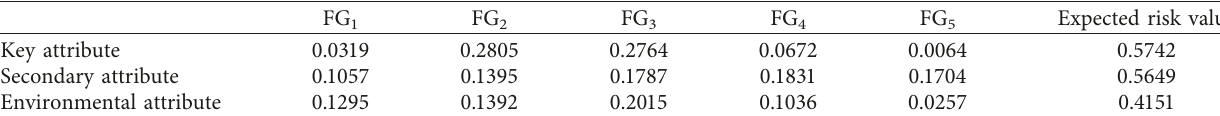
Table 3: Analysis results of risk attributes